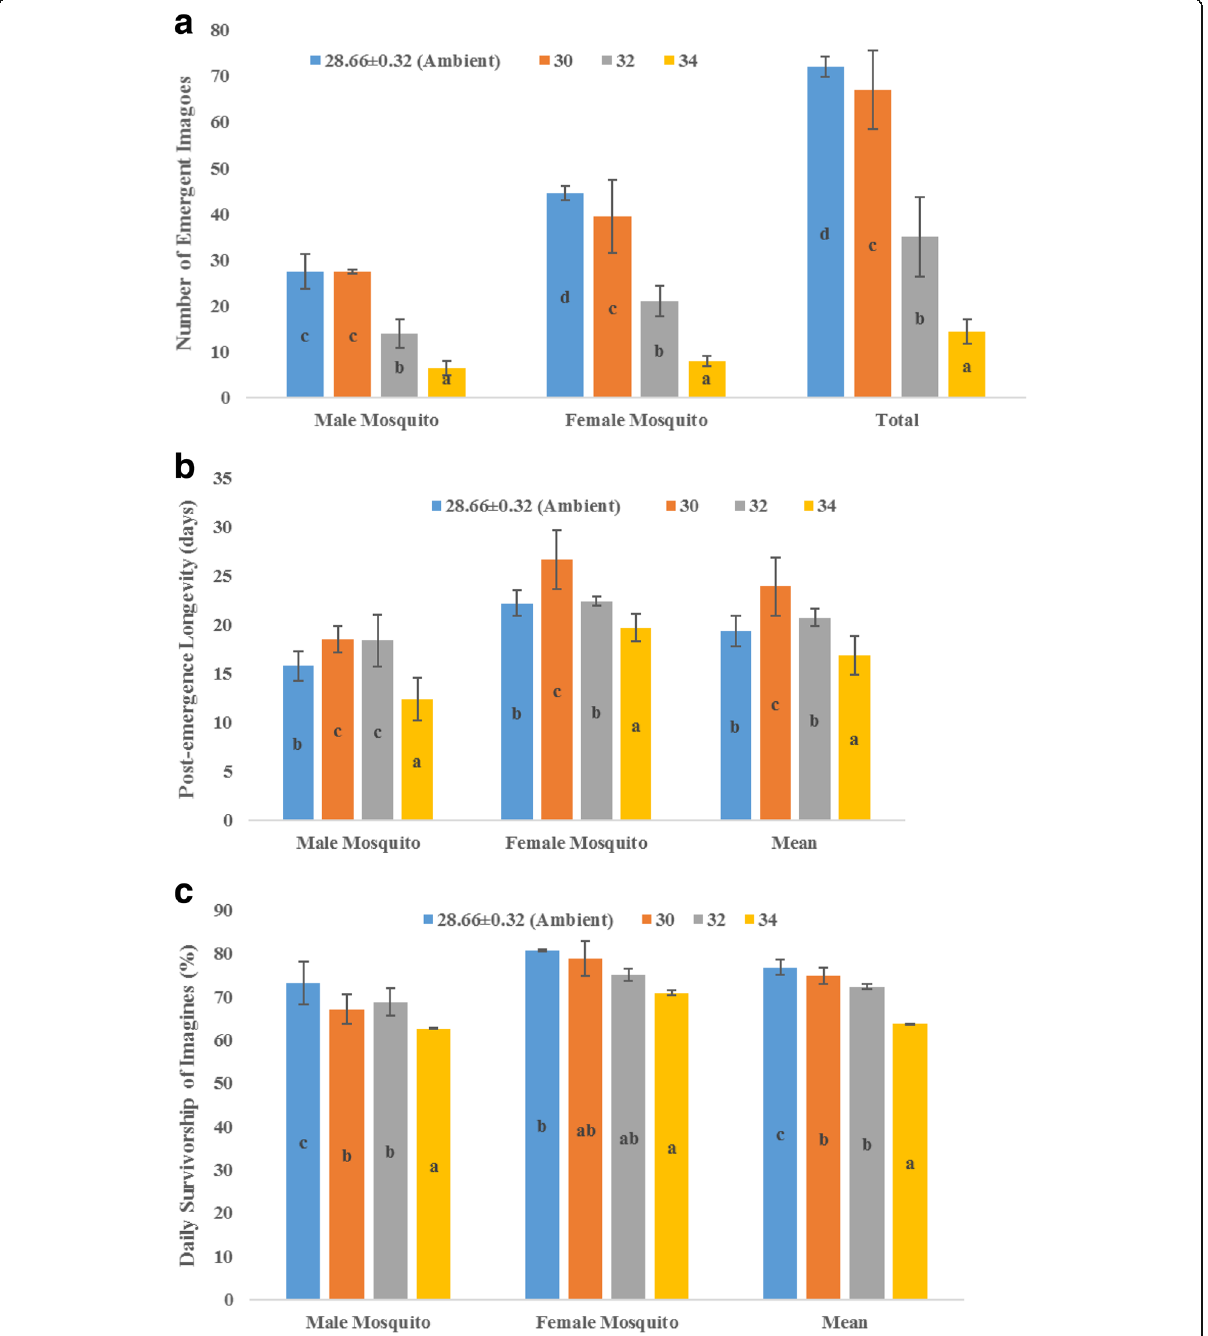
Fig. 3 a Effects of rearing-water temperature on emergence of Culex quinquefasciatus mosquito. Temperature bars with same letter for male, female and total mosquitoes are not significantly different at p <0.05 according to analysis of variance. Values are expressed as mean±SD. b Effects of rearing-water temperature on post-emergence longevity of Culex quinquefasciatus mosquito . Adult were sugar-fed only. Temperature bars with same letter for male, female and mean adult mosquito are not significantly different at p <0.05 according to analysis of variance. Values are expressed as mean±SD. c Effects of rearing-water temperature on daily survivorship of Culex quinquefasciatus mosquito . Adult were sugar-fed only. Temperature bars with same letter for male, female and mean adult mosquito are not significantly different at p <0.05 according to analysis of variance. Values are expressed as